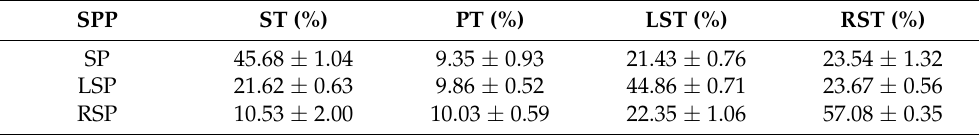
Table 1. Percentage of sleep time in subjects with different sleeping-position preferences.